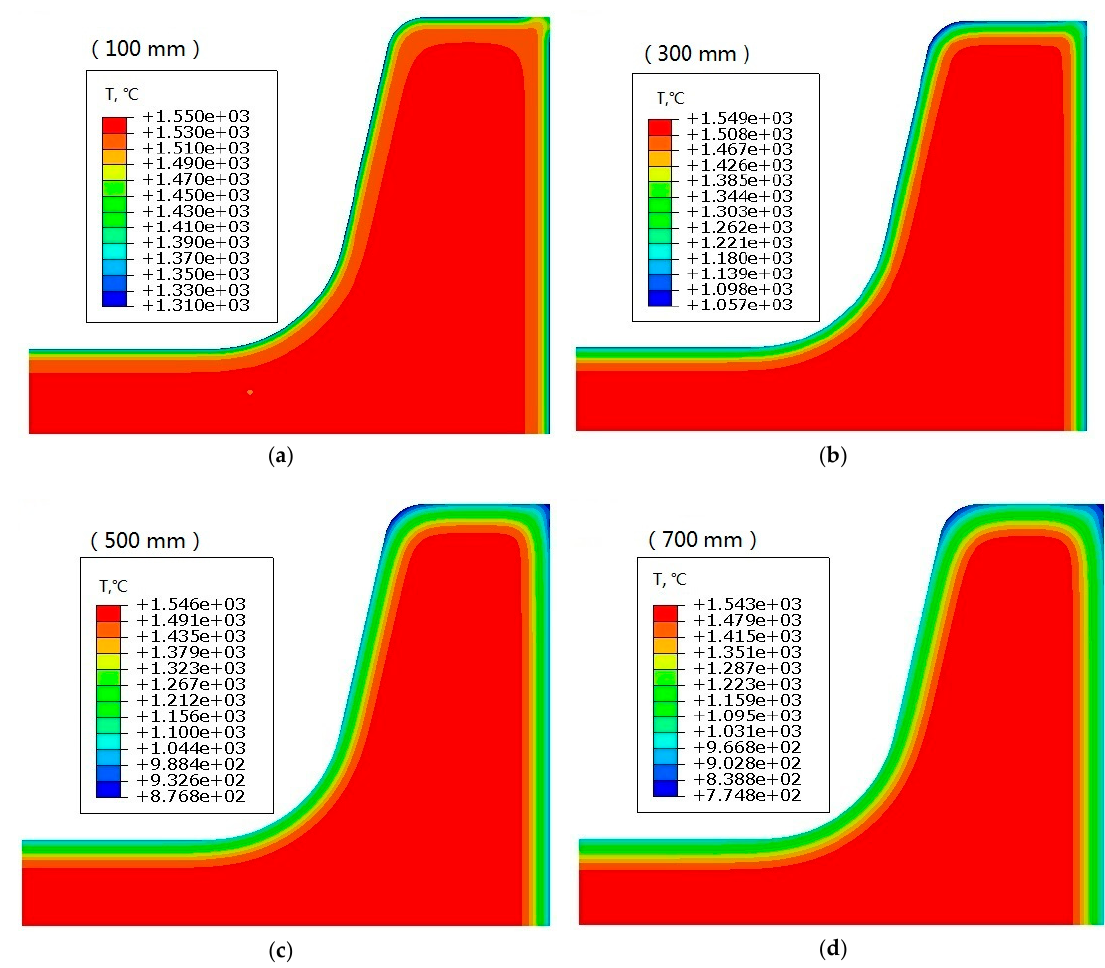
Figure 4. Temperature contours at depths from the meniscus of ( a ) 100 mm; ( b ) 300 mm; ( c ) 500 mm; and ( d ) 700 mm in the mold.